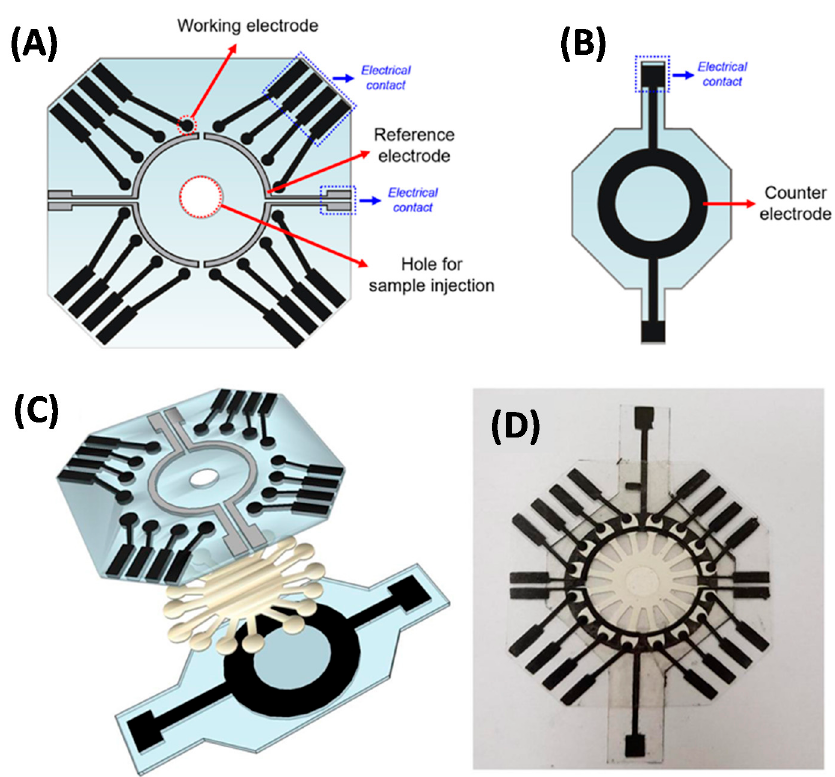
Figure 5. ( A ) Design of the WEs / REs and ( B ) CE layers. ( C ) Steps for device layer assembly. ( D ) Photography of assembled multiplexed PAD. Reprinted from [53] with permission from Elsevier.